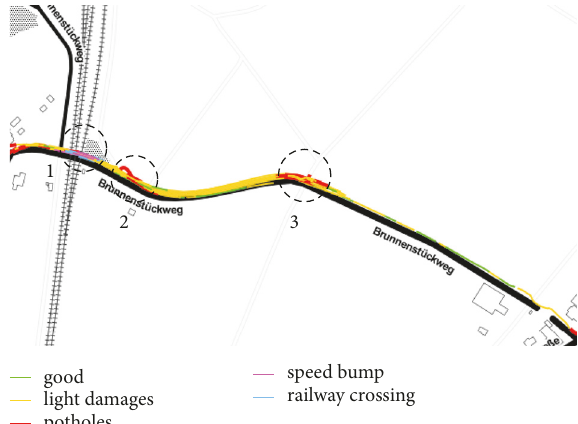
Figure 8: Event classification results of road segments outside of Karlsruhe, Germany, for the events potholes and railways crossing